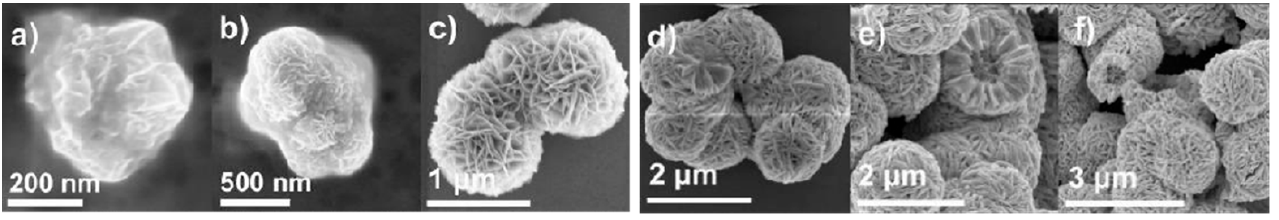
Figure 7. ( a – e ) SEM images of the hollow microsphere samples prepared after 10 min; 15 min; 30 min; 2 h; and 6 h hydrothermal reaction time. ( f ) SEM image of the WO 3 hollow microspheres after annealing